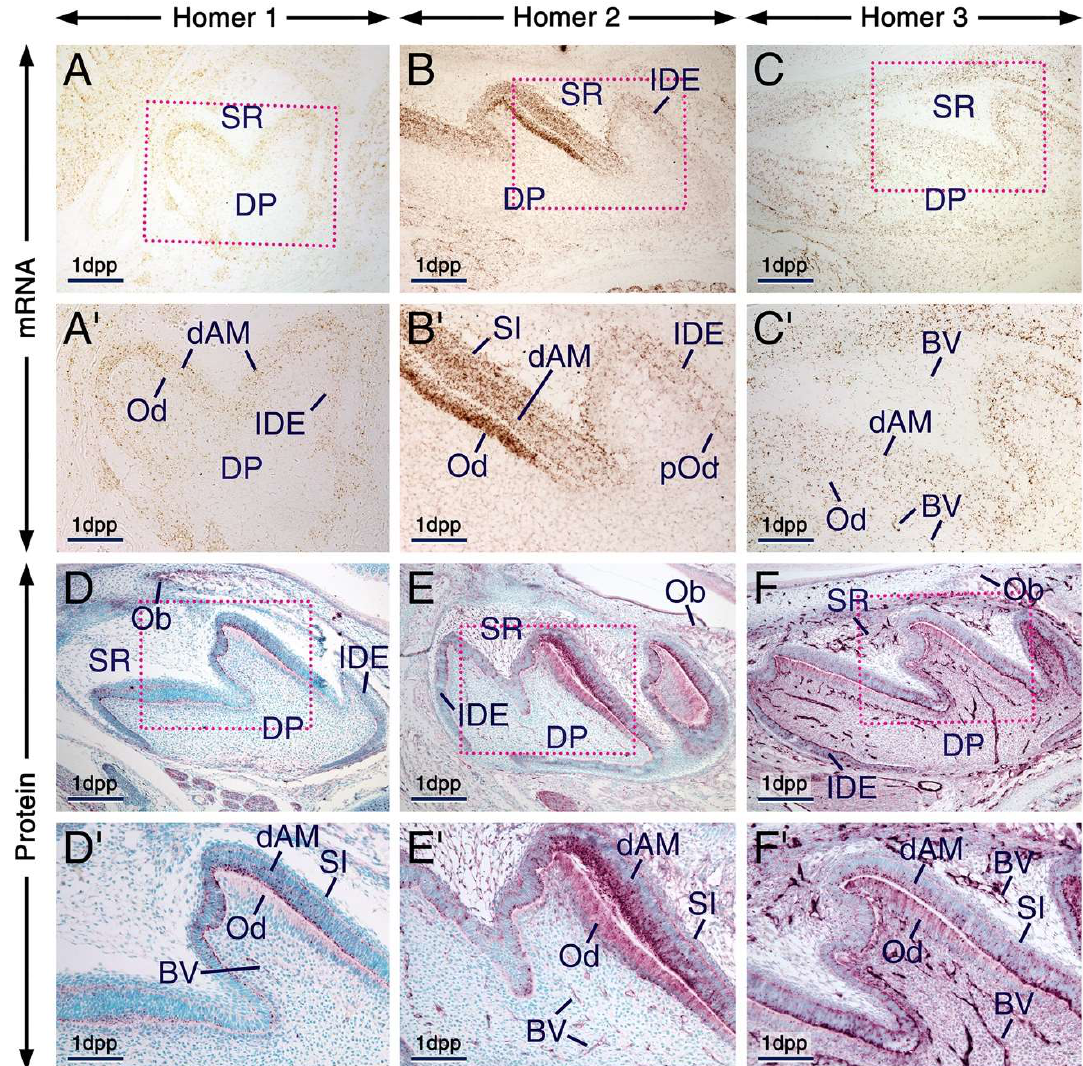
Figure 2. Expression patterns of Homer1, Homer2 and Homer3 during the bell stage of tooth development. ( A – F ) Representative frontal ( A ) and parasagittal ( B – F ) sections across developing first molars at 1 day postpartum (1 dpp) after in situ hybridization ( A – C ) and immunohistochemistry ( D – F ) for Homer1 ( A , D ), Homer2 ( B , E ) and Homer3 ( C , F ). ( A’ – F’ ) are magnified views of the boxed areas in ( A – F ). Odontoblasts and differentiating ameloblasts are enriched with Homer proteins (purple) and mRNAs (brown) as compared to the dental papilla, stellate reticulum and inner dental epithelium. Homer2 protein and mRNA are also expressed in the stratum intermedium. Homer proteins are concentrated in intracellular puncta in odontoblasts and di ff erentiating ameloblasts as well as in cells of the stratum intermedium and inner dental epithelium. The endothelium of blood vessels in the stellate reticulum and dental mesenchyme is enriched with Homer3 mRNA and protein and exhibits weak and moderate immunostaining for Homer1 and Homer2, respectively. Homer proteins are also detectable in osteoblasts within the developing alveolar bone ( D – F ). BV, blood vessels; dAM, di ff erentiating ameloblasts; DP, dental papilla; IDE, inner dental epithelium; Ob, osteoblasts; Od, odontoblasts; pOd, preodontoblasts; SI, stratum intermedium; SR, stellate reticulum. Scale bars: 200 µ m ( A – F ) and 100 µ m ( A’ – F’ ).